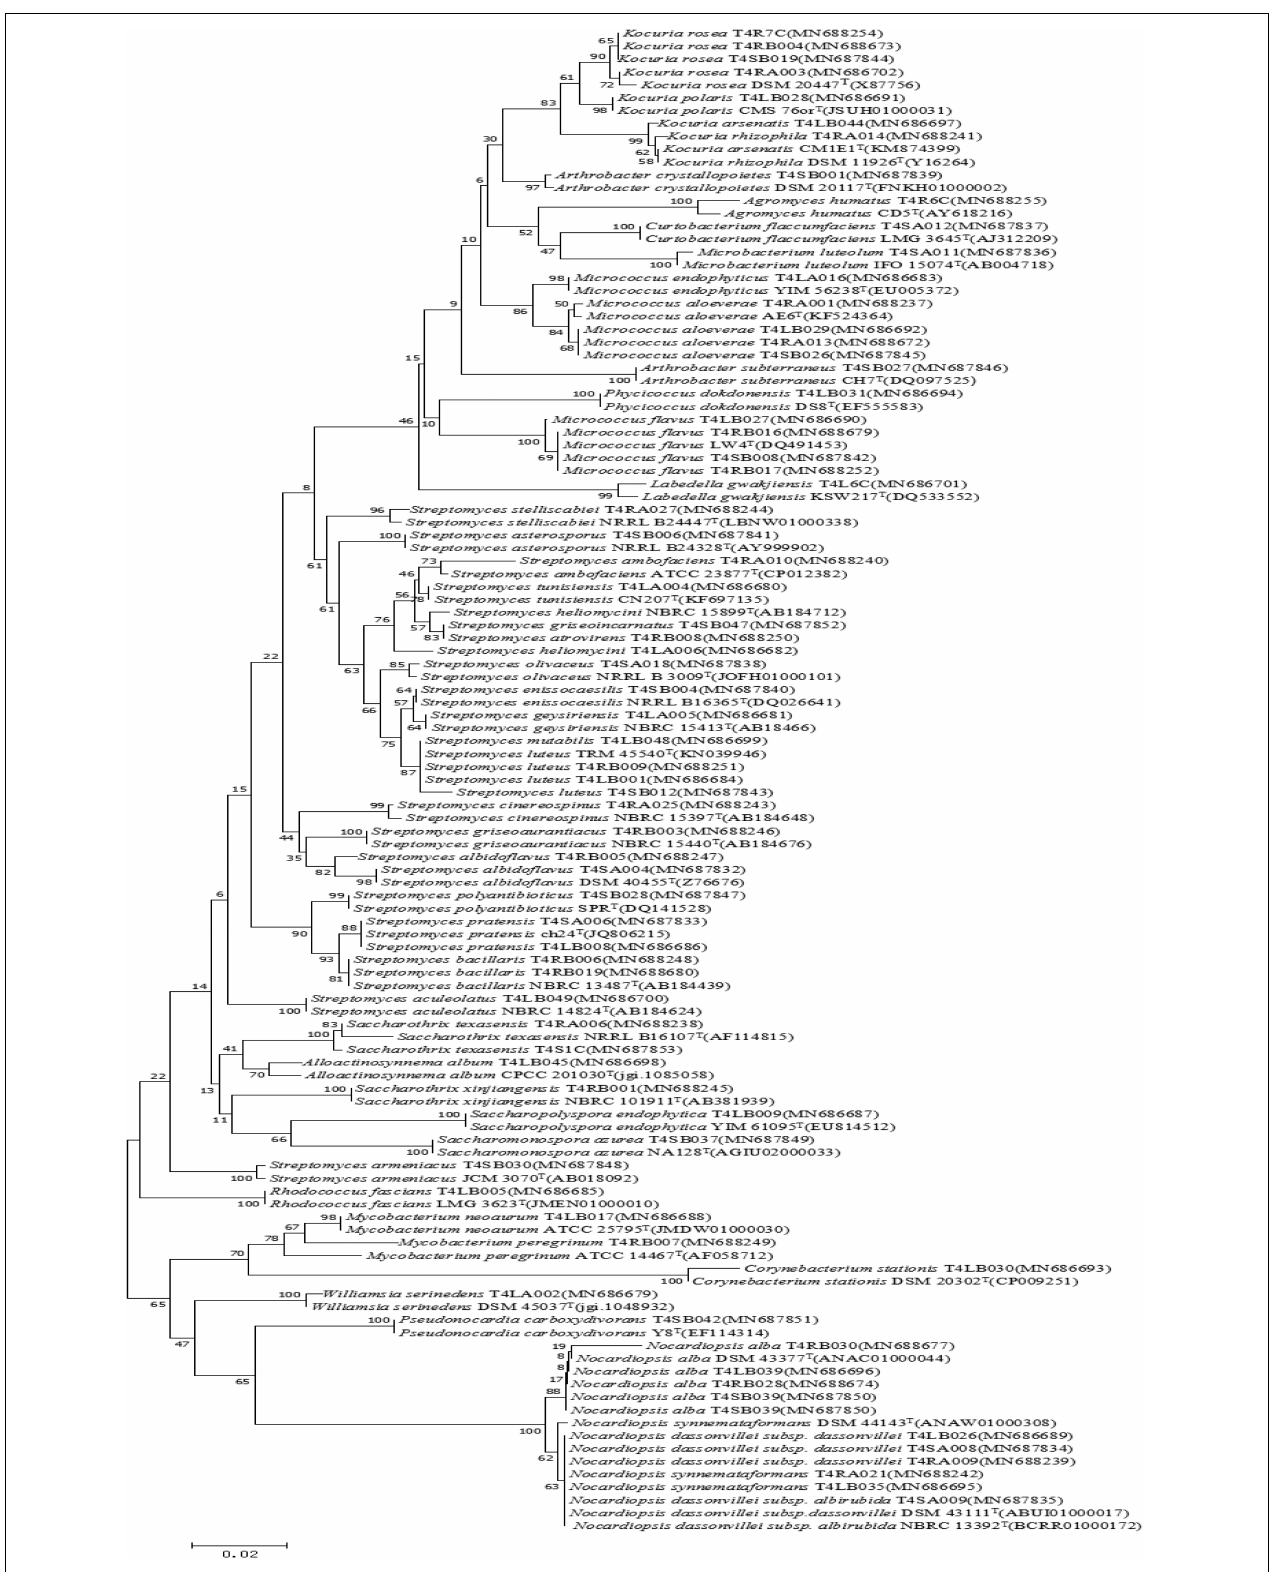
FIGURE 3 | Neighbor-joining tree based on 16S rRNA gene sequences showing relationships between the endophytic actinomycetes (isolated from T. roseus Schipcz. in Tacheng) and the nearest type strains. The bar represents 2% sequence divergence.